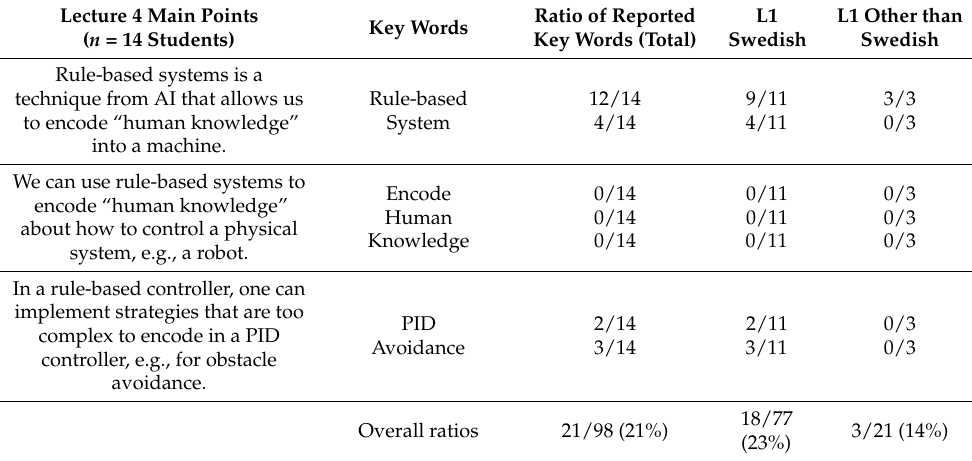
Table 5. Lecture 4 main idea key words comparison.